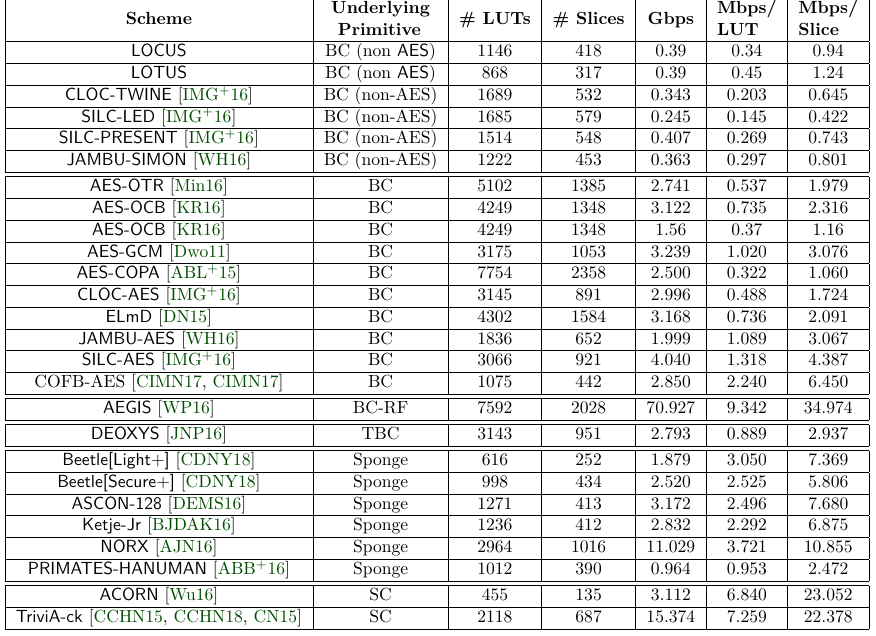
Table 6: Comparison on Virtex 6 [ATHb]. Here BC denotes block cipher, SC denotes Streamcipher, (T)BC denotes (Tweakable) block cipher and BC-RF denotes the block cipher’s round function,‘-’ means that the data is not